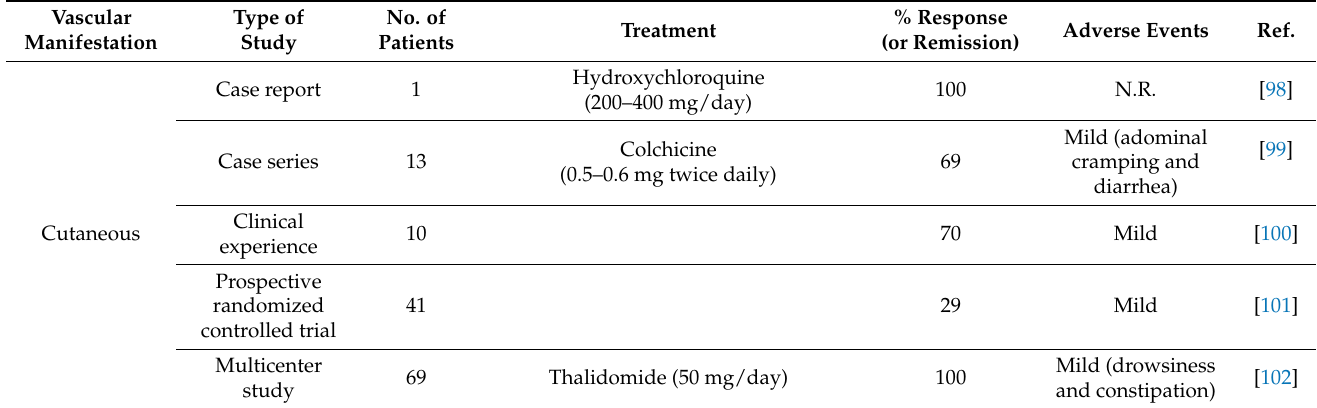
Table 2. The treatments of different vascular manifestations in